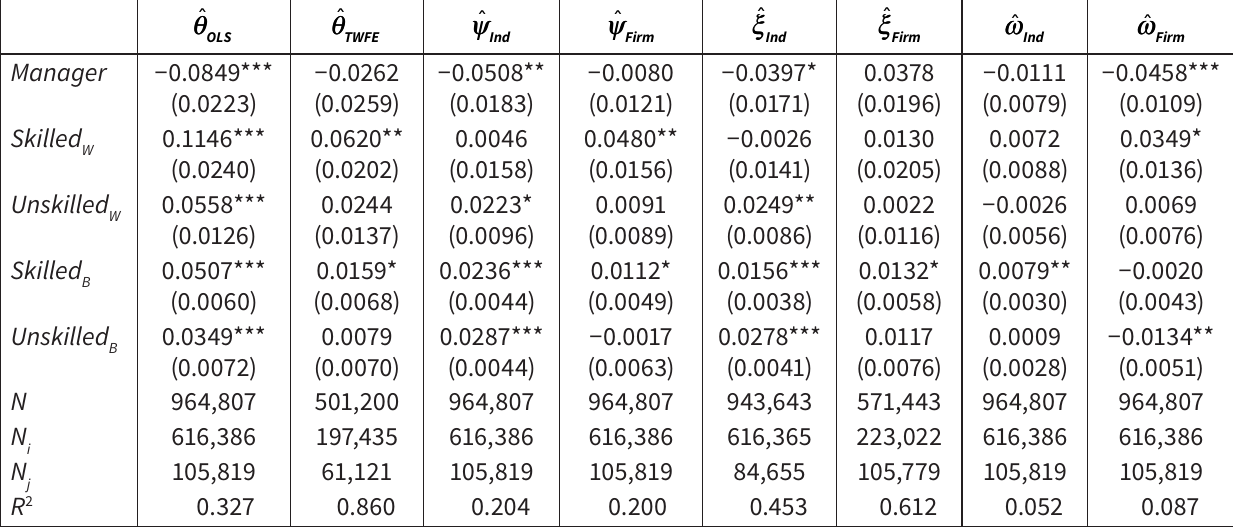
Decomposition of co-worker gains by occupations